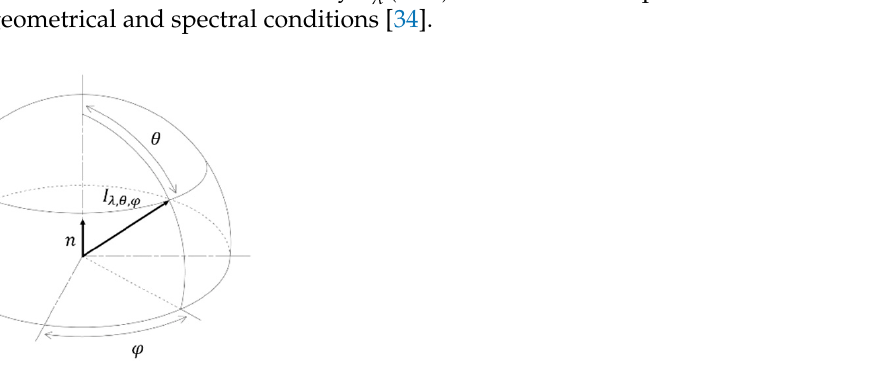
Figure 1. Spectral directional irradiance and polar coordinates as related to a unit hemisphere.